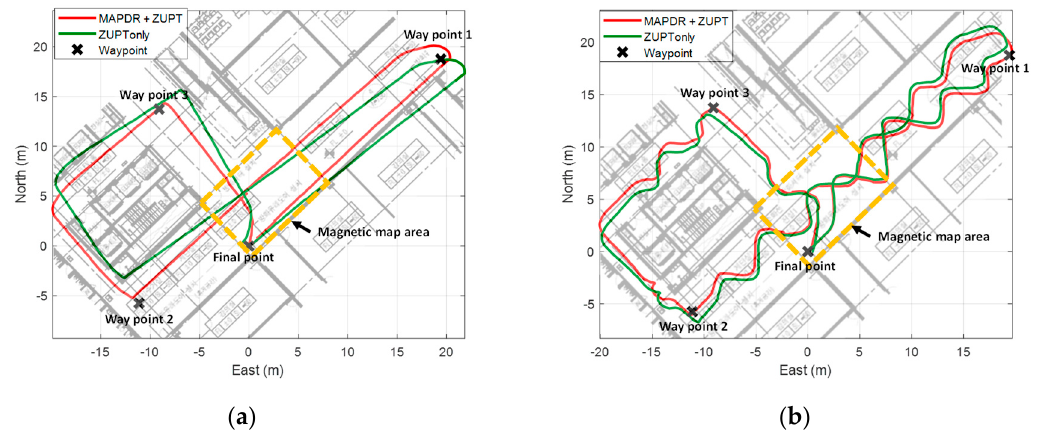
Figure 12. The experiment result of MAPDR with site 2 partial magnetic map ( a ) experiment 1 ( b ) experiment 2.